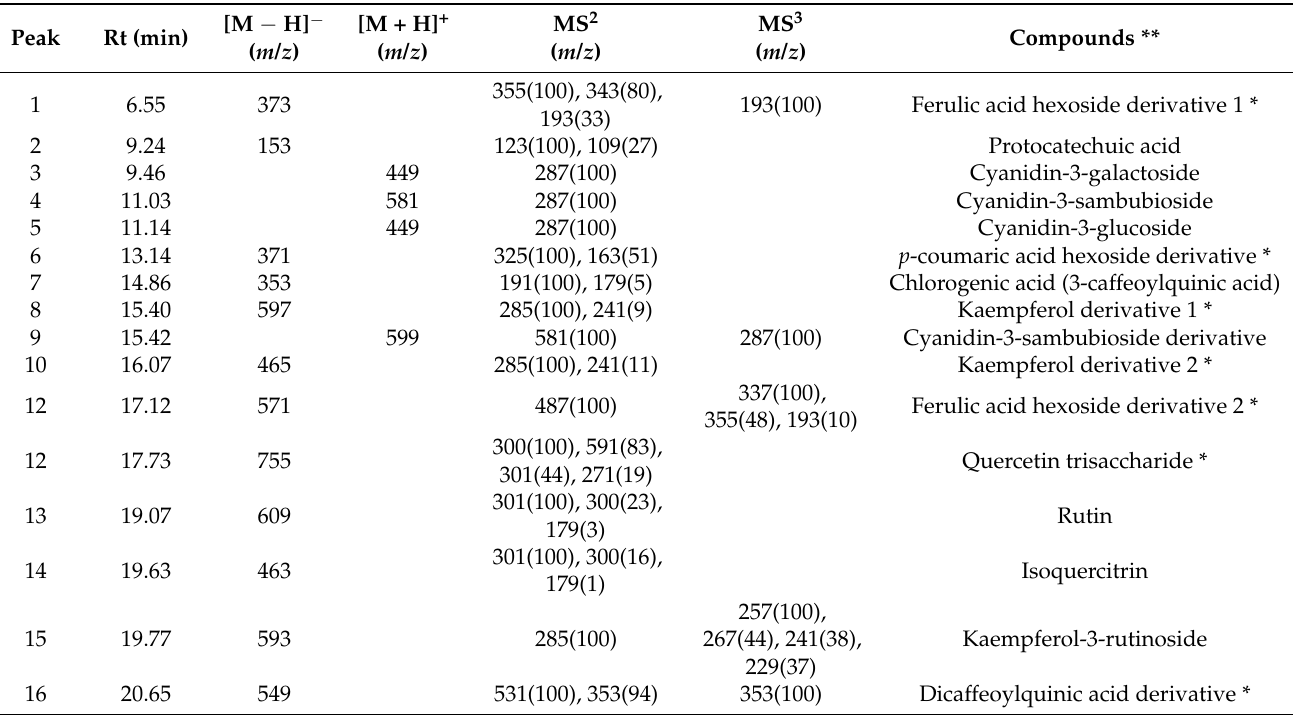
Table 2. Characterized compounds in black elderberry press-cake extracts obtained by different extraction techniques using